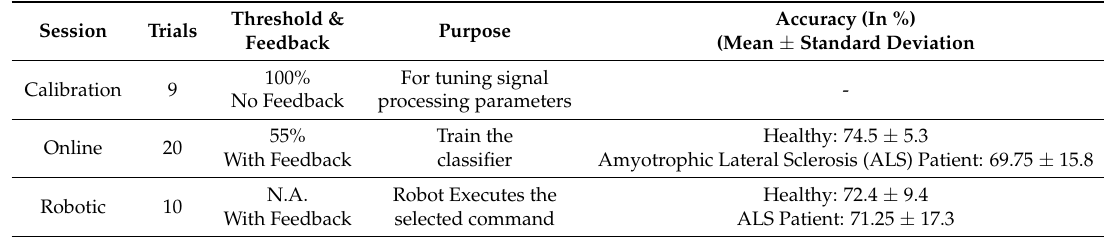
Figure 5. State diagram of process (adapted from: [66]). Table 3. BCI Sessions used in